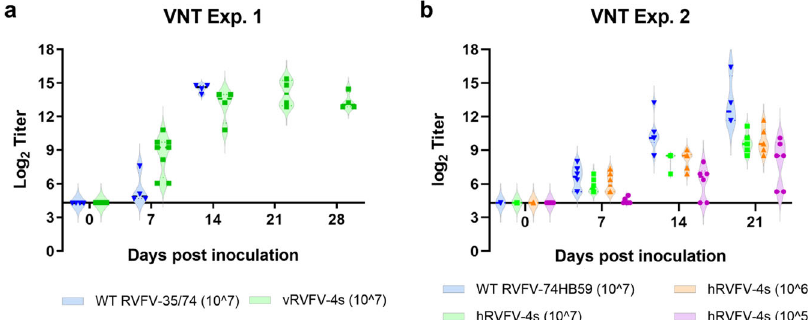
Fig. 7 RVFV-4s inoculation results in the induction of a robust neutralizing antibody response in marmosets. Plasma samples of experiment 1 ( a ) and experiment 2 ( b ) were assessed for the presence of RVFV-speci fi c neutralization antibodies by VNT assay and expressed as neutralization titer 50%. Violin plots (with medians) are presented with x -axes crossing the y -axes at the limit of detection.